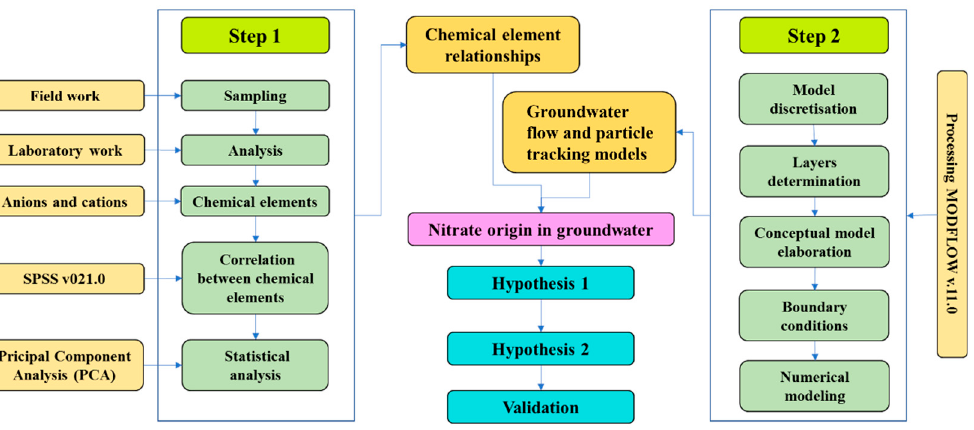
Figure 4. Flowchart showing the methodology adopted for the determination of the NO 3 − origin in groundwater.